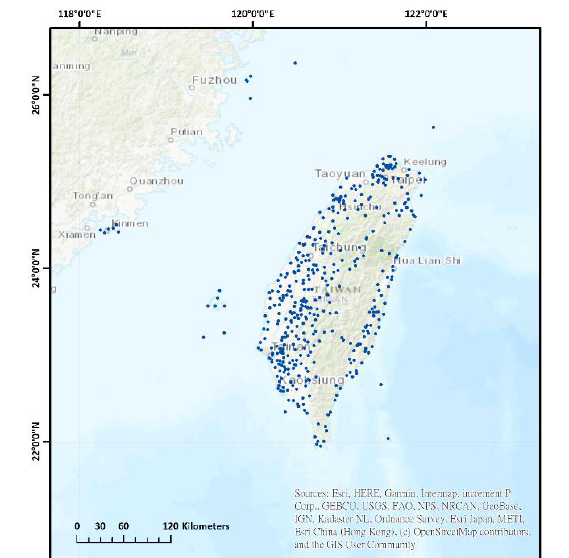
Figure 3. 539 GPS station cover all part of Taiwan. (source: ESRI ArcMap and data sources cited therein)